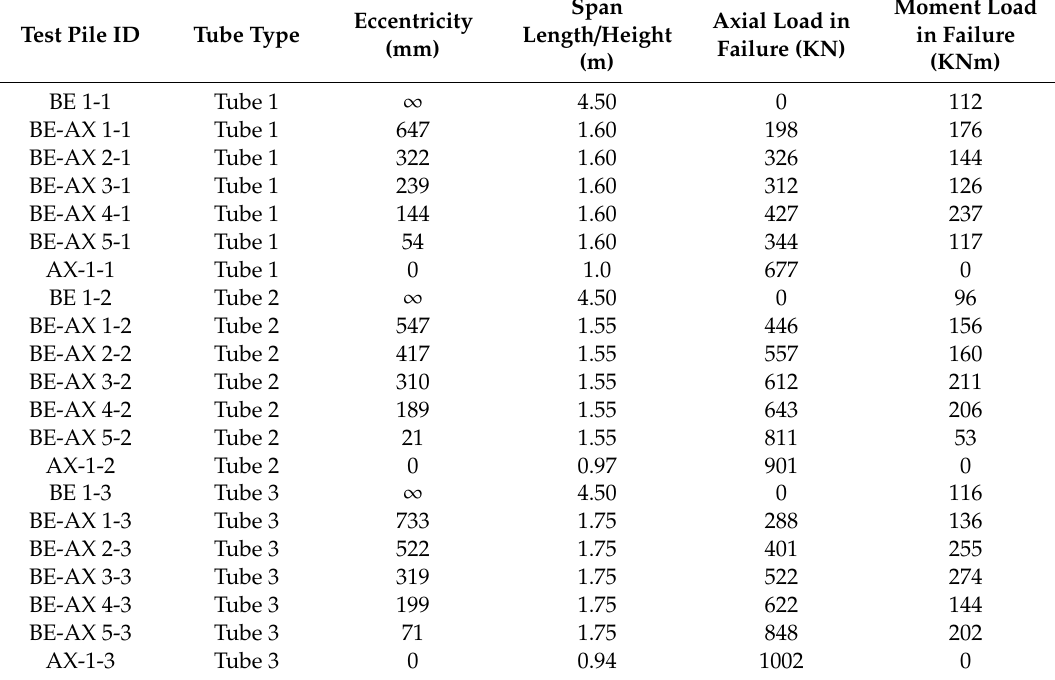
Table 1. Experimental data and specifications of specimens, including beams, concentrically and eccentrically loaded columns.